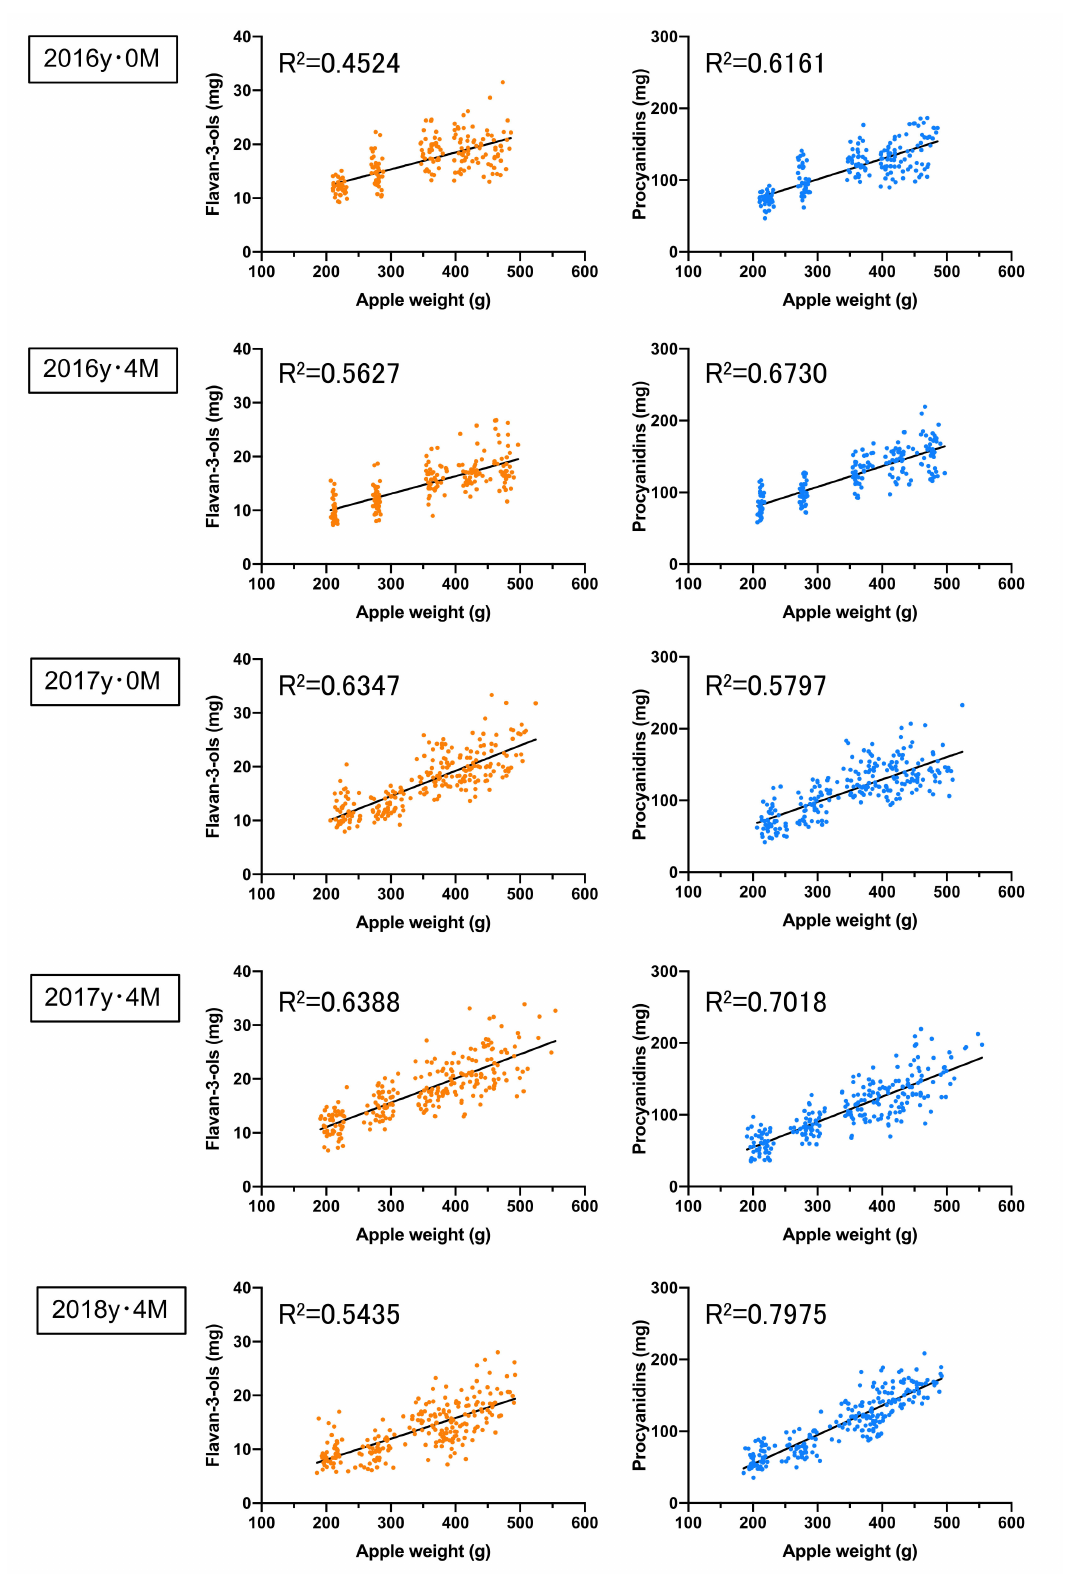
Figure 3. The correlations between the apple weights and both the flavan-3-ol and the procyanidin concentrations in the bagged ‘Fuji’ apples. The apples were analysed in 2016y · 0M ( n = 195), 2016y · 4M ( n = 199), 2017y · 0M ( n = 235), 2017y · 4M ( n = 235), and 2018y · 4M ( n = 237), where y refers to the year, M refers to the month, and n refers to the number of